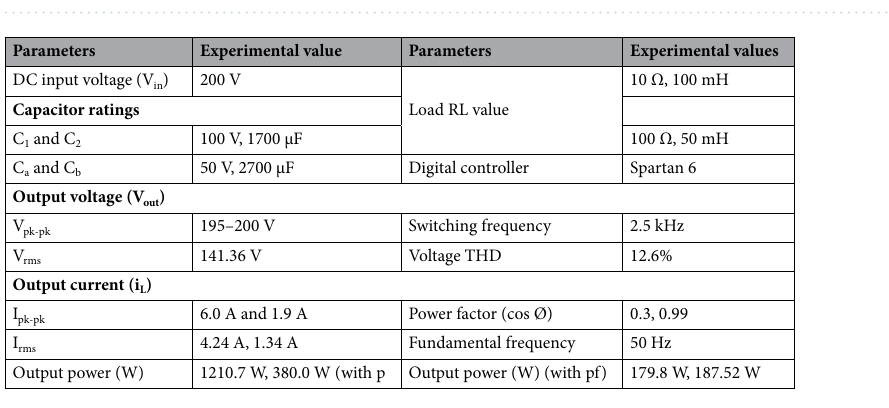
Figure 8. Circuit diagram of proposed 9L ANPC Topology for ( a ) single phase system and ( b ) three phase system.